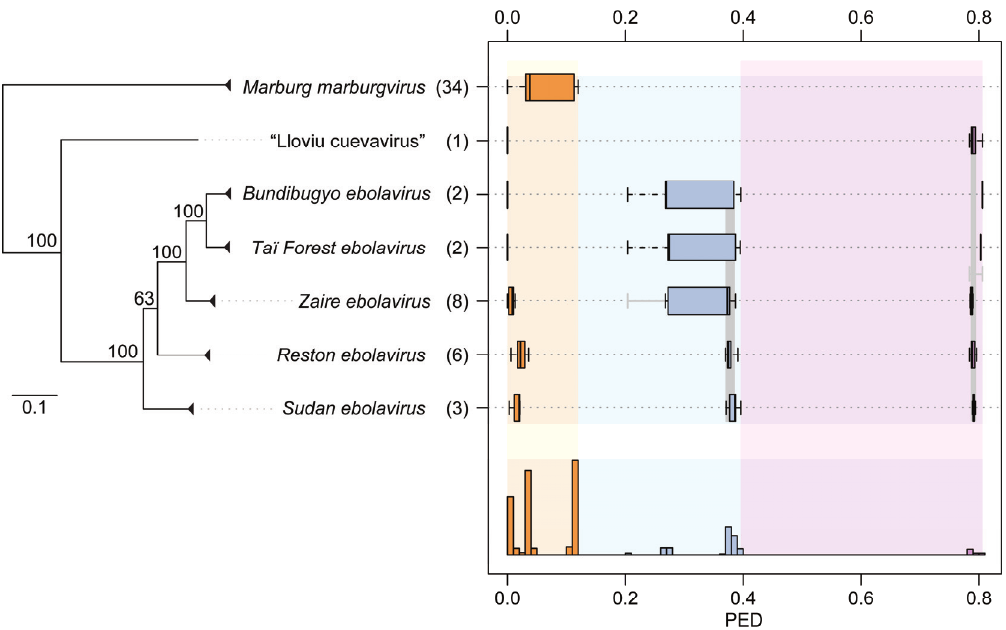
Figure 3. Intragroup genetic divergence of filoviruses. Box-and-whisker graphs are used to plot level-specific PED distributions for the seven clusters of the lowest classification level (bright-shaded orange, blue, and purple). The seven orange clusters correspond to the official or tentative ICTV species of the family Filoviridae [25] and are indicated by names; virus sampling per ICTV species is shown in brackets. The combined PED distributions of clusters of the second and third level are shown as gray box-and-whisker graphs. The expected range of level-specific PED values, bordered by two distance thresholds, is indicated by light-shaded background colors. The respective part of the PED distribution covering the full range of intragroup PED values of the three levels is show at the bottom. The ICTV species are grouped vertically according to a maximum likelihood phylogeny shown at the left. Internal nodes of the tree that correspond to ICTV species are collapsed (triangles); all of them have a bootstrap support value of